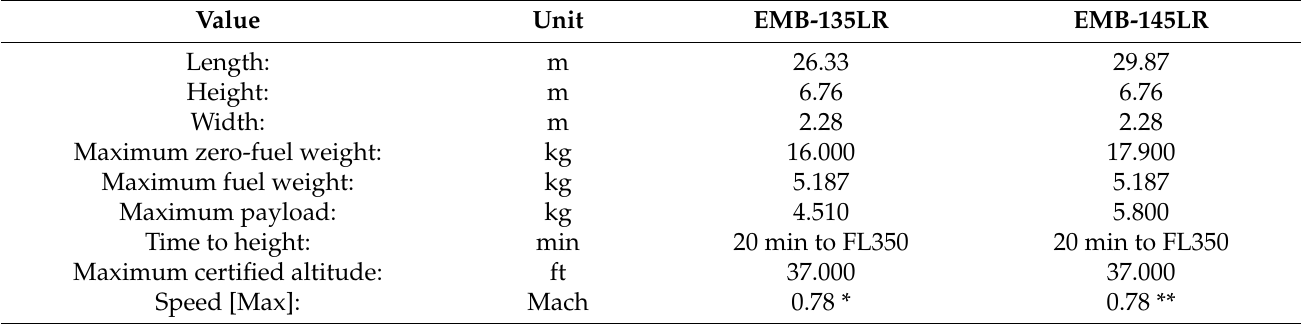
Table 1. Aircraft Basic Characteristics